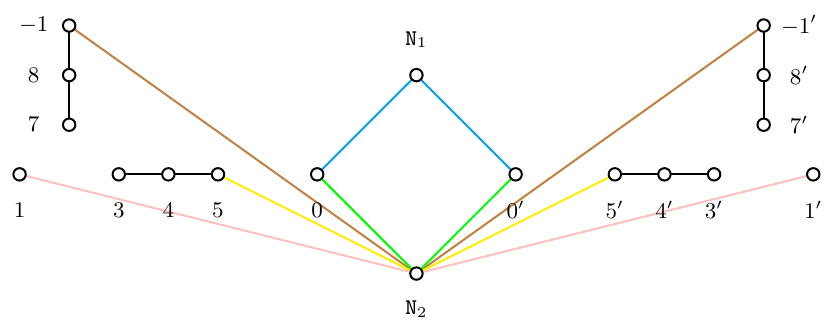
Figure 14. Dynkin diagram showing the chosen connection for the node N 1 (in cyan, corresponding to the root j 1 ; 0 ; 1 ; 0; 0 8 ; 0 8 i ) and the possible connections for the node N 2 (in pink, green, yellow and brown; corresponding respectively to the roots (1)-(4) in